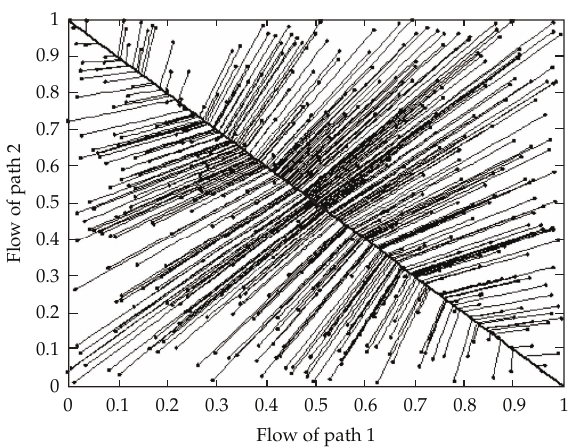
Figure 2: State trajectories demonstrating stability of